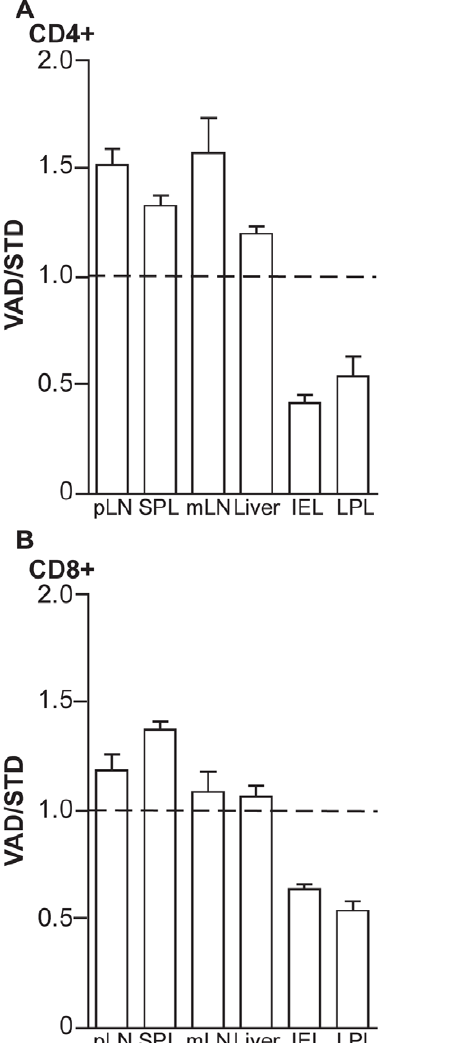
Figure 2. Homing of allo-primed T cells to the intestine is dependent on dietary vitamin A. 2 6 10 7 splenocytes (C57BL/6) were transferred into lethally irradiated STD or VAD BALB/c recipients. Three days after transfer donor T cells from mesenteric lymph nodes of STD or VAD BALB/c mice were harvested and then split and differentially labeled with either TAMRA or CFSE. CFSE-labeled cells from STD recipients were mixed with TAMRA-labeled cells from VAD- recipients at a 1:1 ratio. In cross-labeling experiments, TAMRA-labeled cells from STD-recipients and CFSE-labeled cells from VAD-recipients were used. Mixtures of 5 6 10 6 T cells per mouse in total were injected into the tail vein of untreated wt C57BL/6 recipient mice. Eighteen hours after transfer recipient mice were sacrificed and the homing of CD4 + and CD8 + T cells was analyzed by flow cytometry. The ratio of transferred T cells primed in allogeneic VAD versus STD recipients was analyzed in pLN (pooled per mouse), SPL, mLN, liver, IEL and LPL. Labeling effects were excluded by normalizing the ratio to 1:1 in each staining group. N=6/group. Data are combined from two independent experiments.